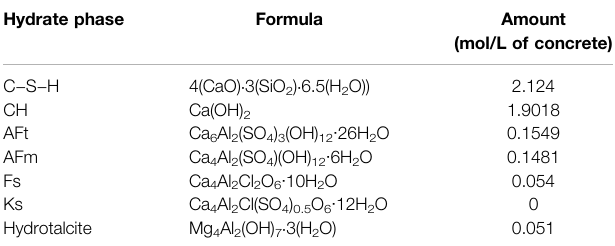
TABLE 4 | Hydrated cement